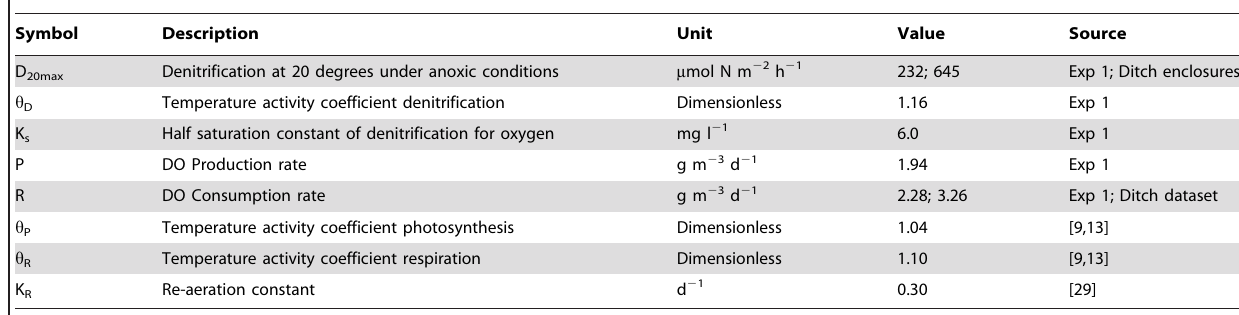
Table 2. Model parameter